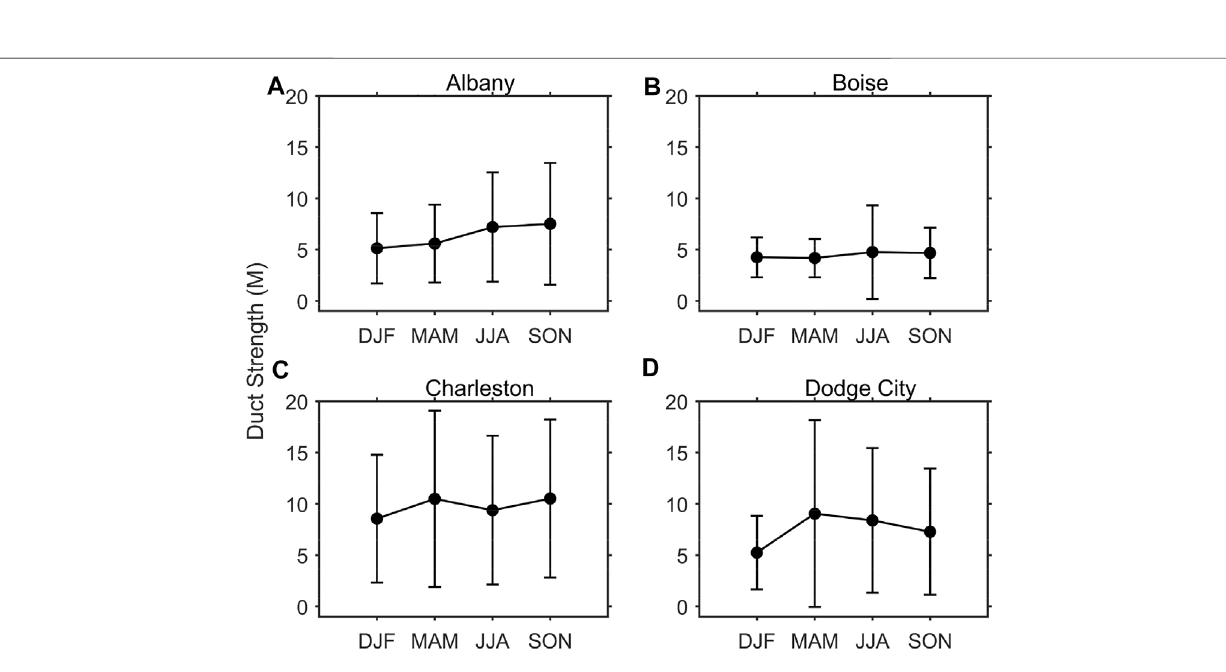
Frontiers in Environmental Science |